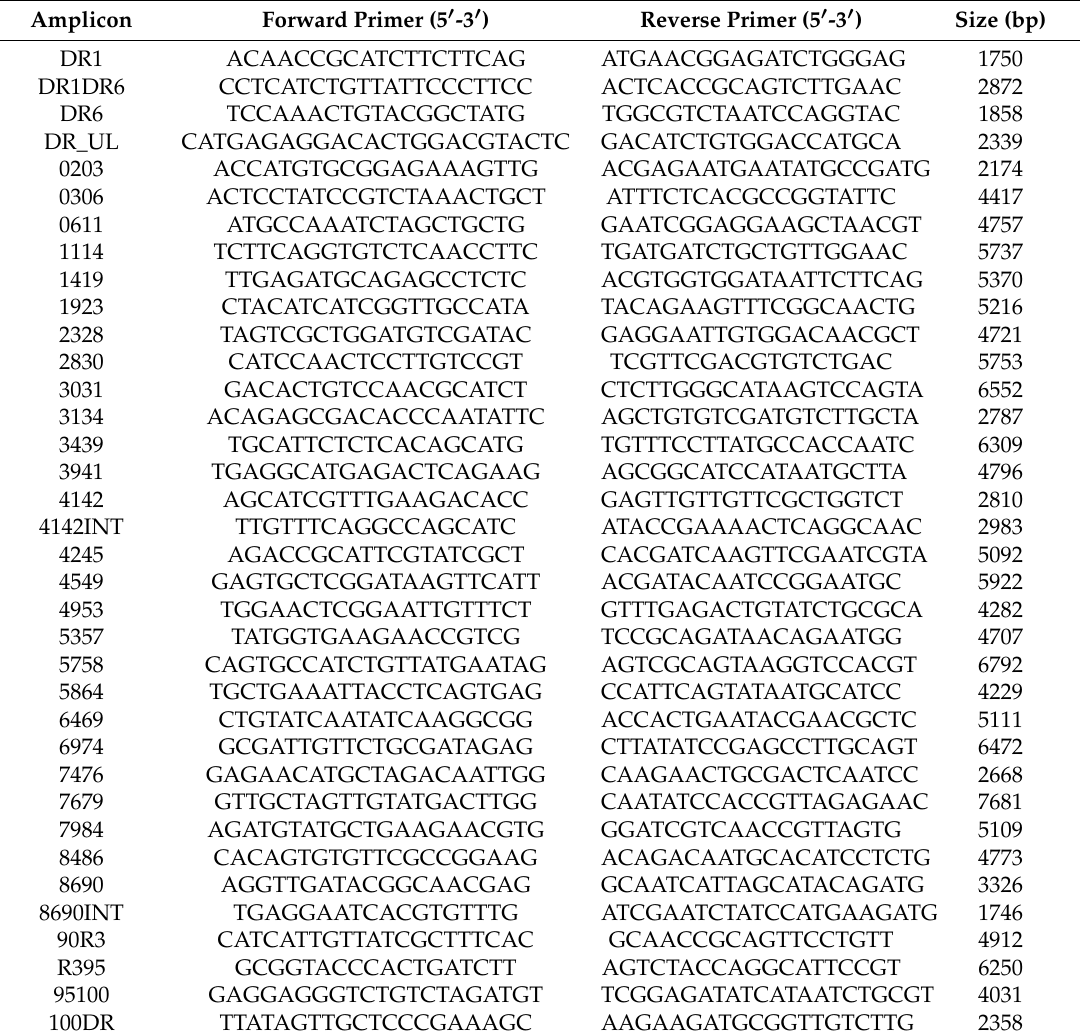
Table 1. Long range PCR genome amplicon